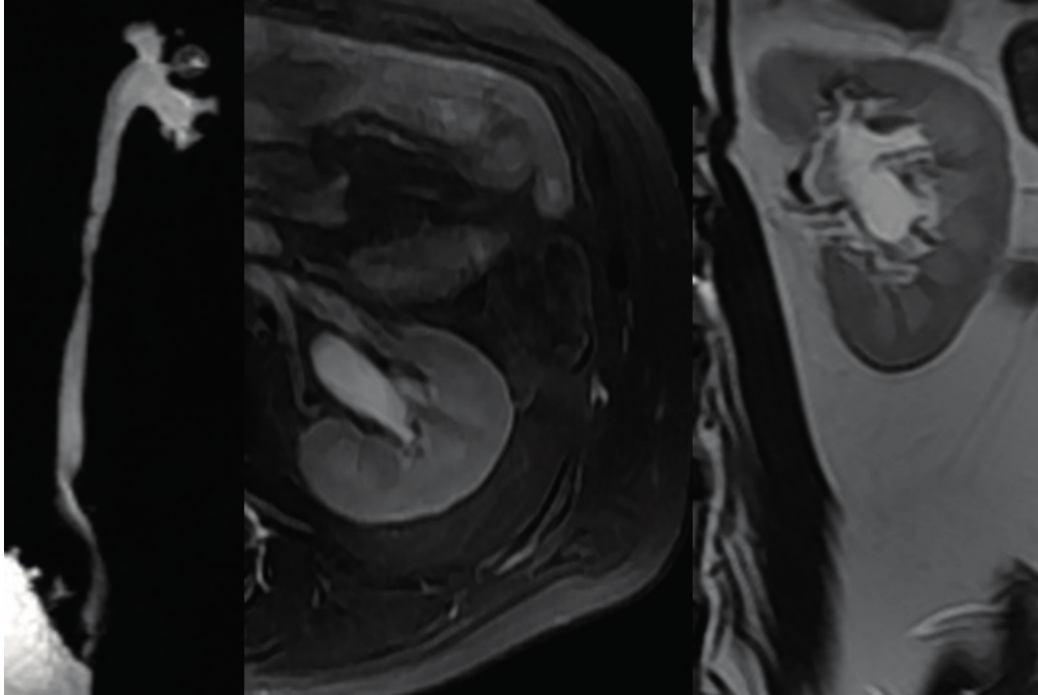
Figure 4. Grade 2 with UUTD-MRU grading system.